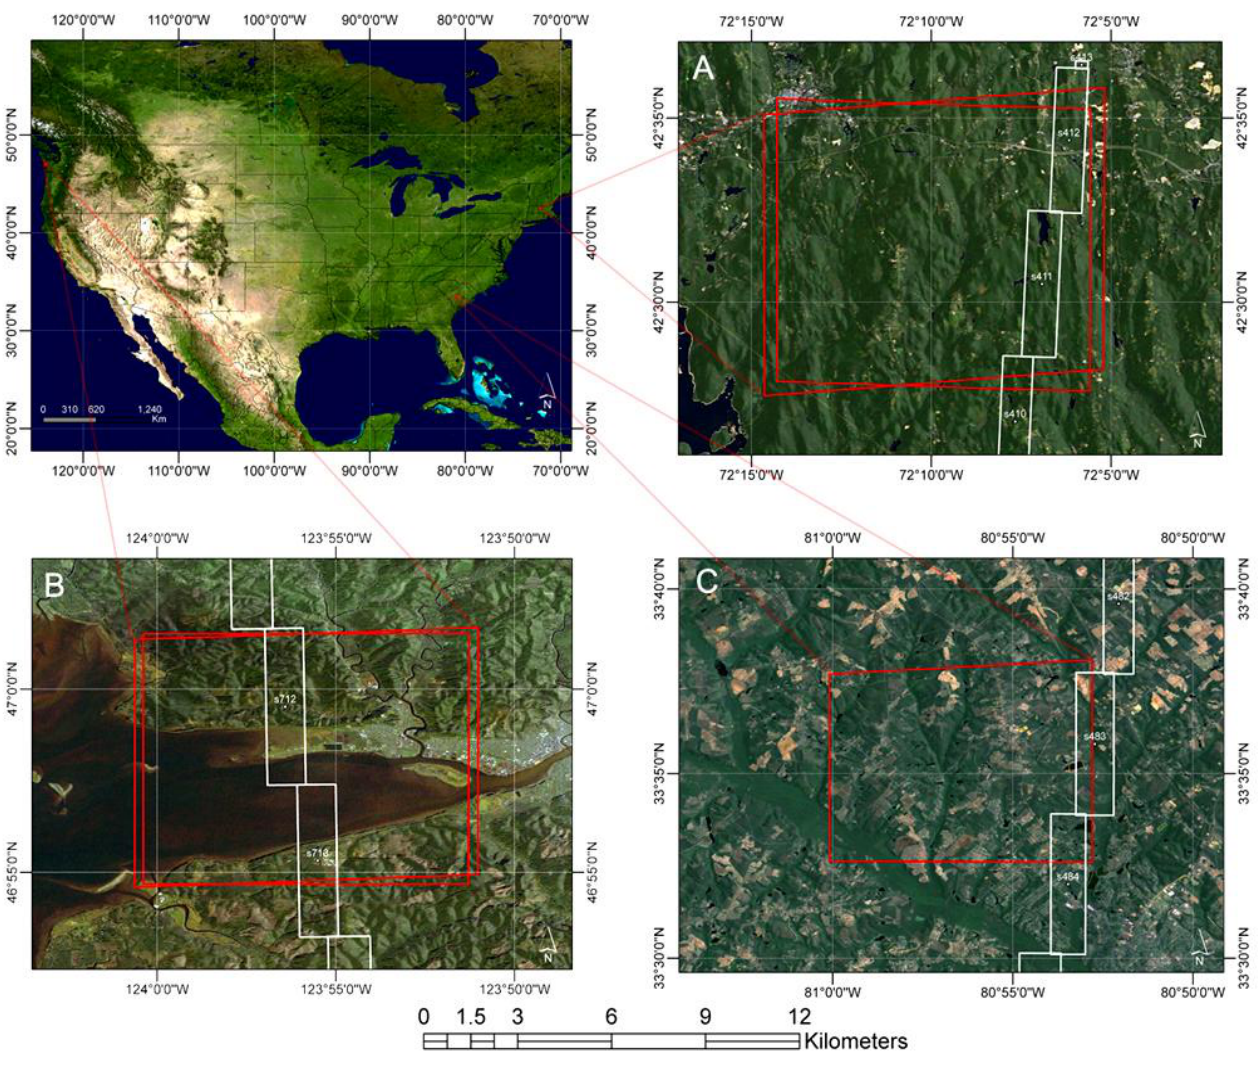
area locations. Panels ( A ) Harvard Forest, Massachusetts; ( B ) Hoquiam, Washington; and ( C ) Jamison, South Carolina show I-cubed 1 m seamless color mosaic of commercial and government imagery with tiled G-LiHT products indicated with white quadrangles and IKONOS stereo footprints indicated with red